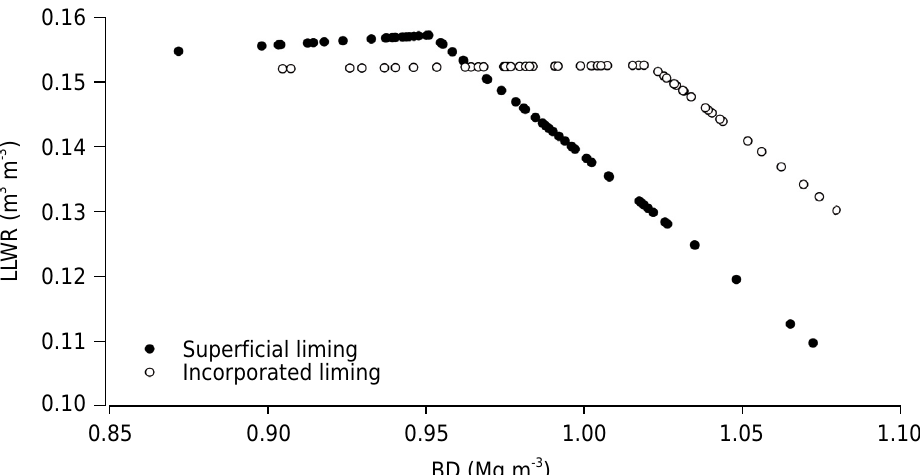
Figure 7. Least limiting water range (LLWR) in function of bulk density (BD) for surface liming and incorporated